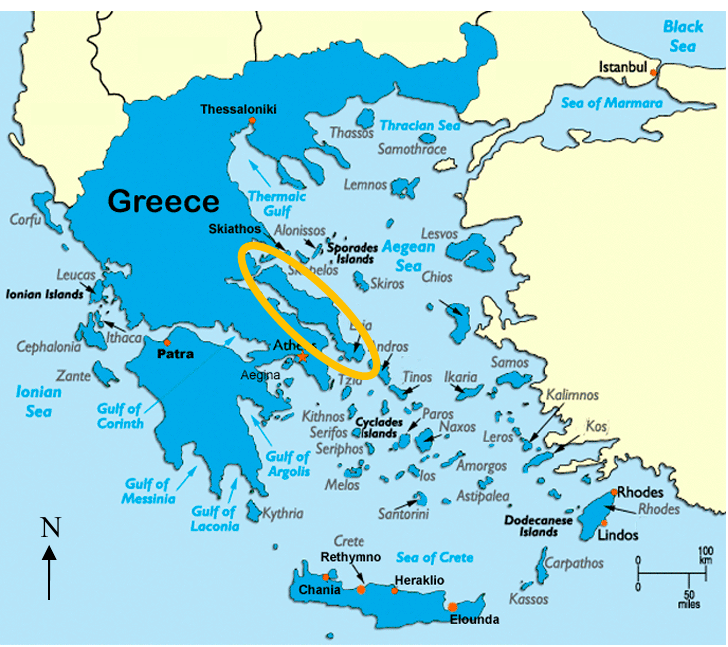
Figure 2. Map of Greece showing the area of study, Evia prefecture [15].